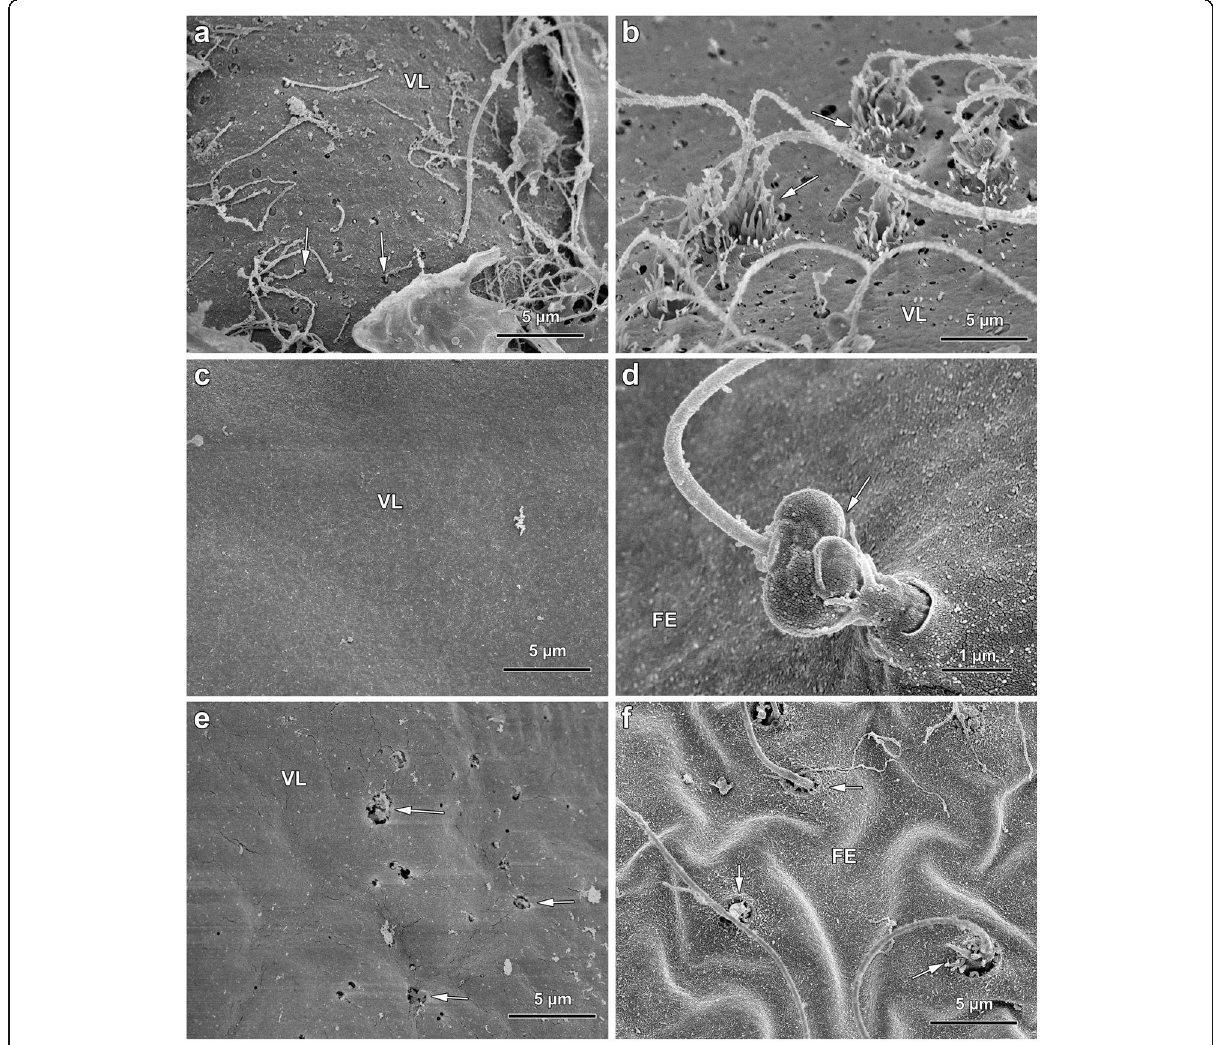
Fig. 2 Scanning electron micrographs of the surface of immature, mature and overripe eggs of P. pectinifera before and after fertilization. a An immature oocyte showing the projections of the follicle cells (FC, arrows) penetrating the vitelline layer (VL). b Polyspermic fertilization of an immature oocyte. Note the formation of the fertilization cones made by a large number of long microvilli protruding from the porous VL (arrows) and capturing the multiple sperm for their incorporation. c An oocyte treated with 1-MA for 50 min showing the VL without the openings characteristically present in the surface of immature oocytes in A. d The surface of a control egg fertilized at its optimal period of maturation (50 min 1-MA treatment) shows that, at variance with the multiple sperm penetration in immature oocytes shown in B, only the fertilizing sperm is captured by cytoplasmic protrusions emanating from the fertilization envelope (FE) (arrow). Note the different structure of the fertilization cone which is formed at this stage of maturation. e The structural modification of the VL of the overripe eggs makes this envelope more similar to that of immature oocytes and its openings. f Multiple sperm penetration (arrows) through the FE in an overripe egg upon